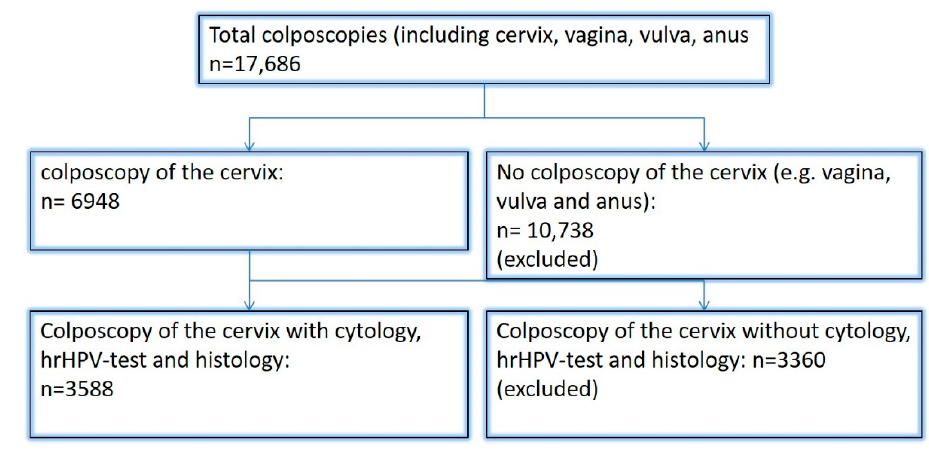
Figure 1 . Flowchart. Figure 1. Flowchart. Table 2. Pap and HPV in Combination with Histology for the whole set of